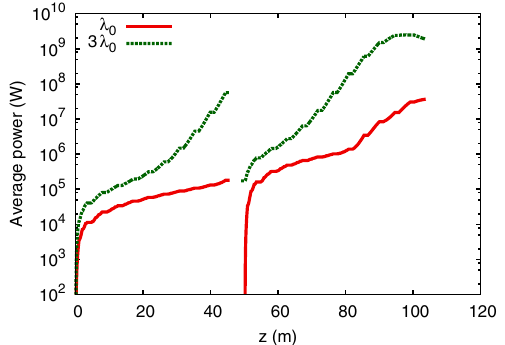
FIG. 13. Average power produced at a fundamental of 0.9 nm and at the (nonlinear) third harmonic for a self-seeded beam line.